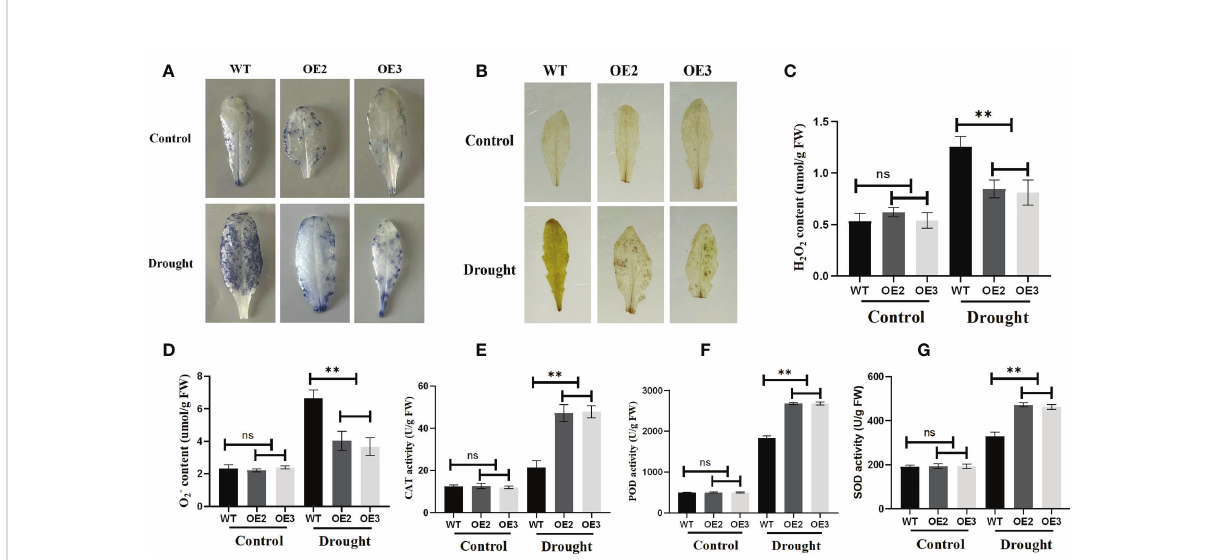
FIGURE 10 Reactive oxygen species staining and physiological indices in ZmLBD2 transgenic Arabidopsis. (A) NBT staining of leaves for H 2 O 2 from ZmLBD2 transgenic seedlings and wild-type plants under normal conditions and drought stress (30 days seedlings were subjected to drought for 10 days). (B) DAB staining of leaves for H 2 O 2 from ZmLBD2 transgenic seedlings and wild-type plants under normal conditions and drought stress (30 days seedlings were subjected to drought for 10 days). (C, D) H 2 O 2 and O − 2 content in leaves from ZmLBD2 transgenic seedlings and wild- type plants under normal conditions and drought stress. CAT activity (E) , POD activity (F) , and SOD activity (G) in leaves from ZmLBD2 transgenic seedlings and wild-type plants under normal and drought conditions. Data were expressed as the mean of triplicate values, and error represented the SD. The ** represents p < 0.01, respectively. Non-signi fi cant (ns).